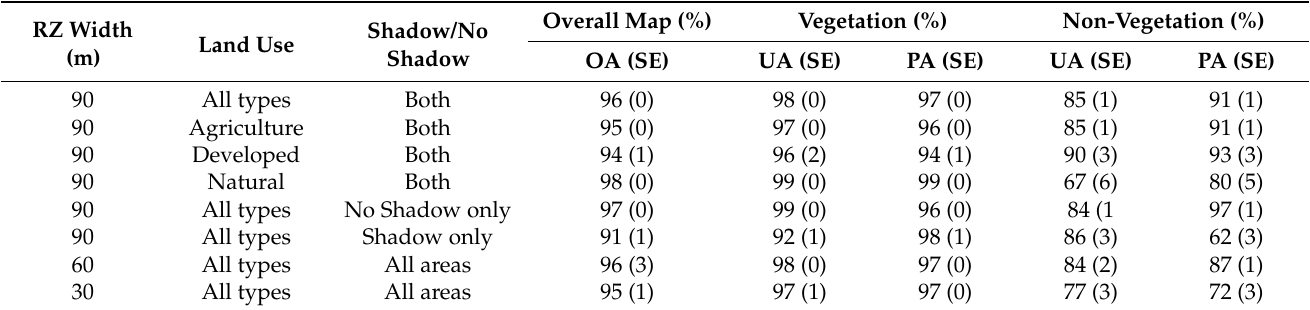
Table 4. Riparian vegetation classification accuracy riparian zone along Stockport and Kinderhook Creeks characterized by land use and image shadow presence (full confusion matrices are provided in Table